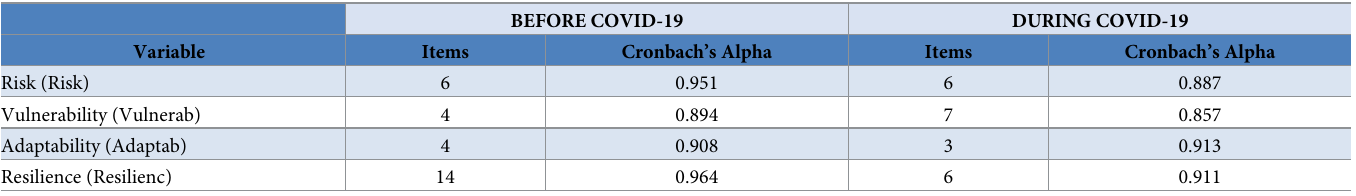
Table 1. Cronbach’s Alpha